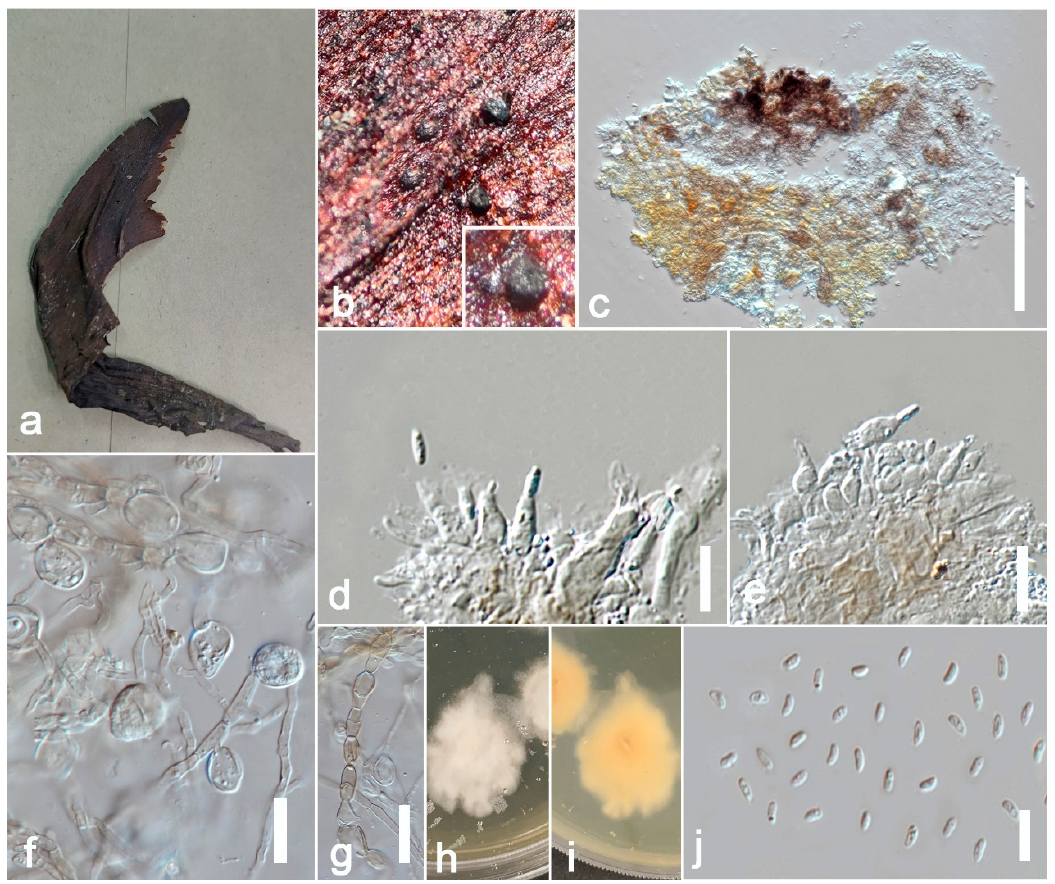
Figure 3. Allophoma tropica (ZHKU 22-0099) ( a ) Examined material. ( b ) Conidiomata on the substrate. ( c ) Vertical section of a conidioma. ( d , e ) Conidiogenous cells attached to conidia. ( j ) Conidia. ( f , g ) Chlamydospores in cultures. ( h , i ) Colonies on PDA ( i from the bottom). Scale bars: e = 200 µ m, f – j = 10 µ